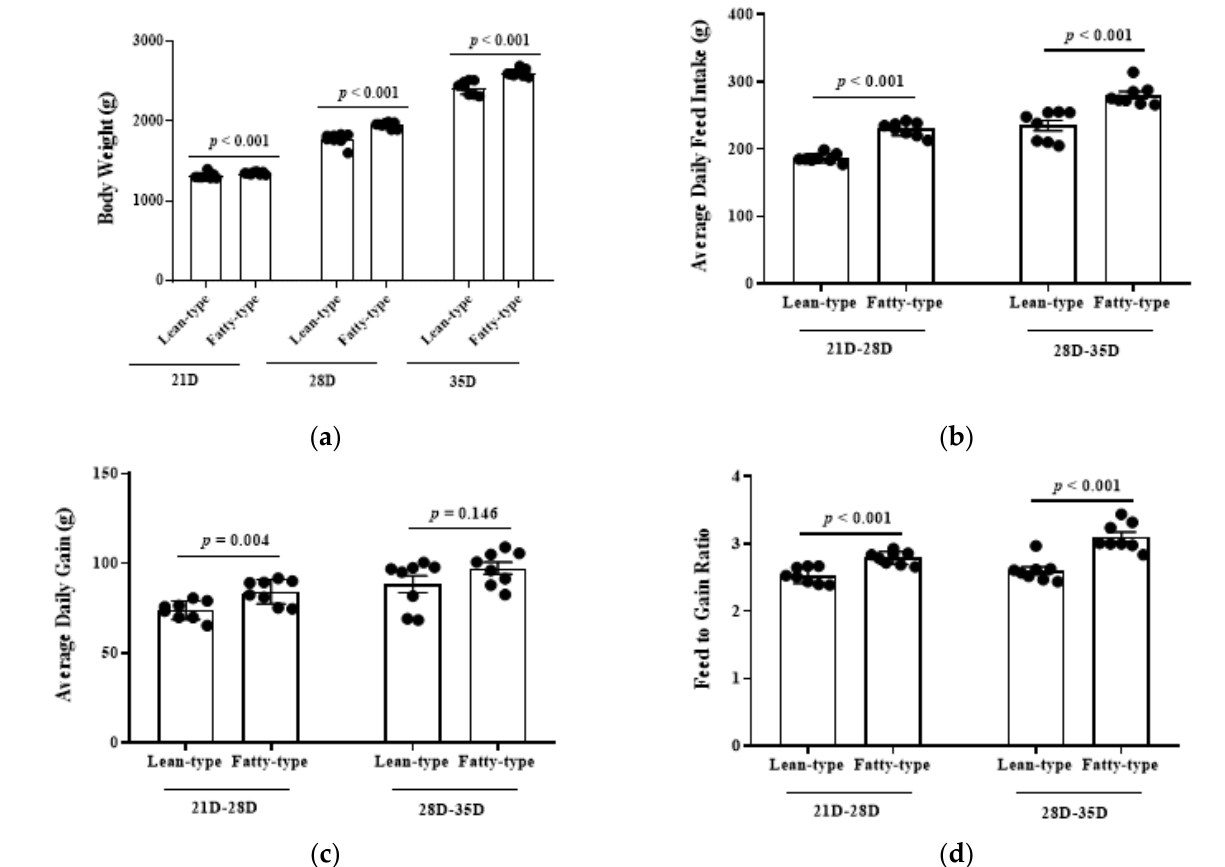
Figure 1. Comparison of body weight ( a ) average daily feed intake ( b ), average daily gain ( c ), and feed-to-gain ratio ( d ) between two strains of meat duck. Values were compared for statistical analysis on three measuring days (21 D, 28 D, and 35 D). Data are given as means and standard error of the mean ( n = 8). p -values are shown after comparison of two strains. Table 3. Comparison of serum biochemical parameters between Lean-type ducks and Fatty-type ducks at 35